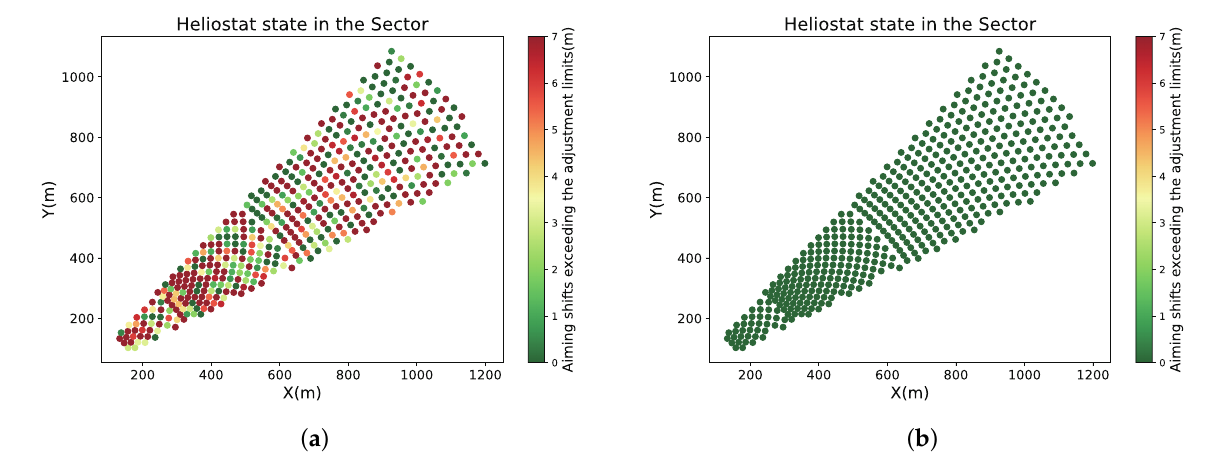
Figure 9. Extent to which the heliostat aiming exceeds the adjustment limits of ( a ) PSO-based aiming strategy and ( b ) MPC-based aiming strategy.